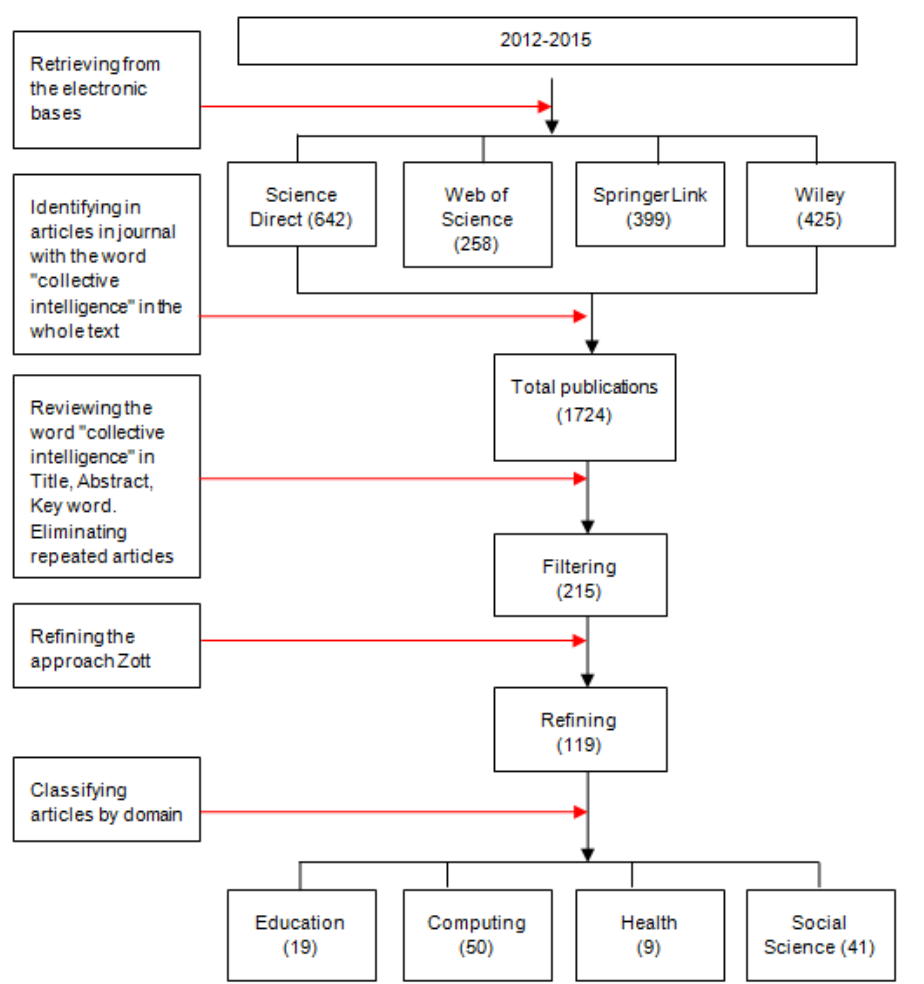
Figure 2 . Scheme followed for the selection of the